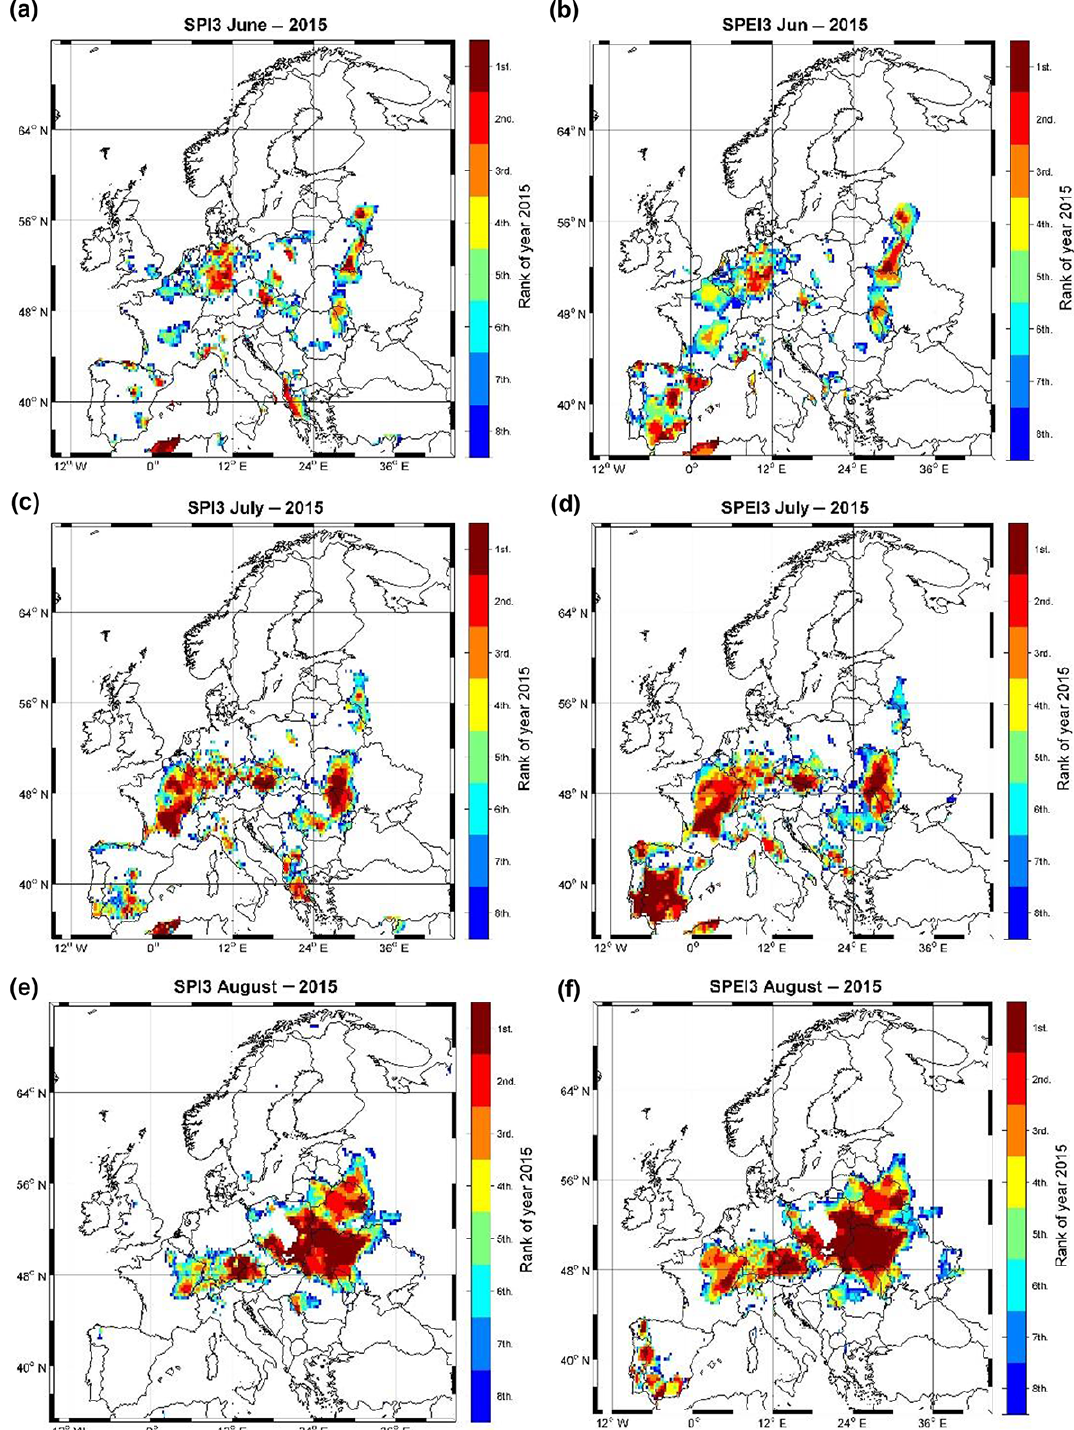
Figure 3. Top-eight ranking of 2015 monthly SPI3 (left column) and 2015 SPEI3 (right column): (a) June SPI3; (b) June SPEI3; (c) July SPI3; (d) July SPEI3; (e) August SPI3 and (f) August SPEI3. 1 means the driest month since 1950, 2 signifies the second driest, etc., and all ranks greater than 8 are shown in white. Analyzed period: